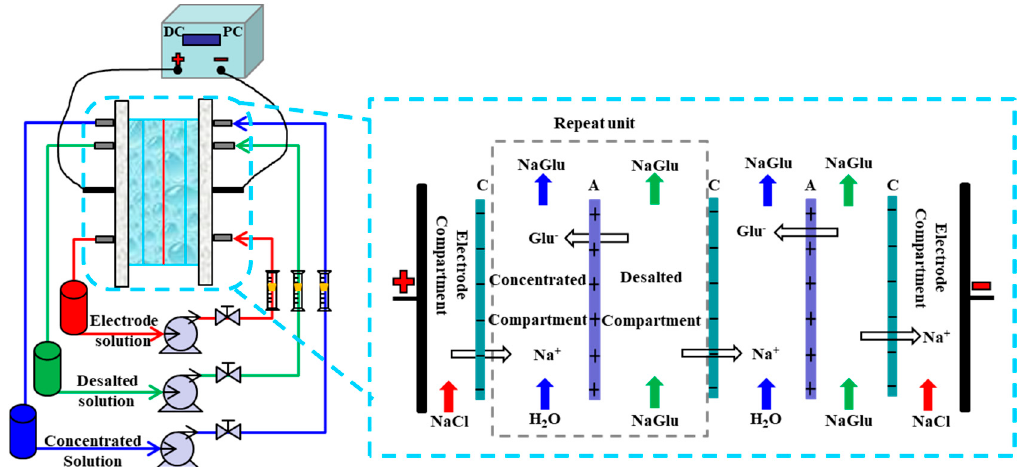
Figure 2. Schematic representation of the ED applied to separation sodium gluconate from the sodium gluconate mother liquor. A: AEM, C: CEM.